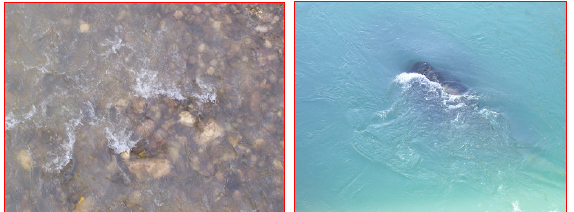
Figure 1: Turbulence as observed in a river. Here we can see different turbulent wakes due to different obstacles (simple stones) emerging naturally above the water